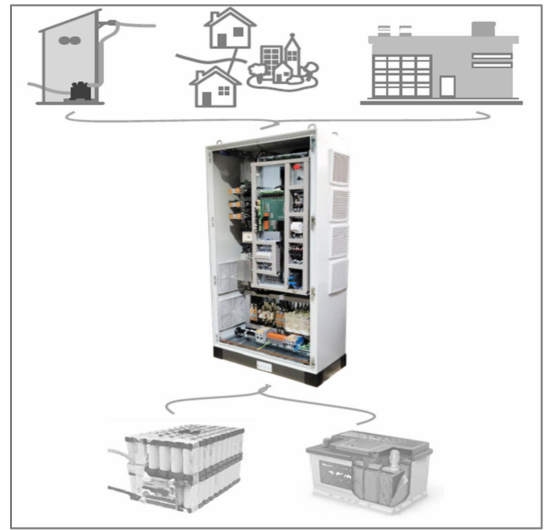
Figure 7. PED as developed in the project shows possibilities to integrate multiple batteries (at the bottom), as well as to use them in multiple contexts (on